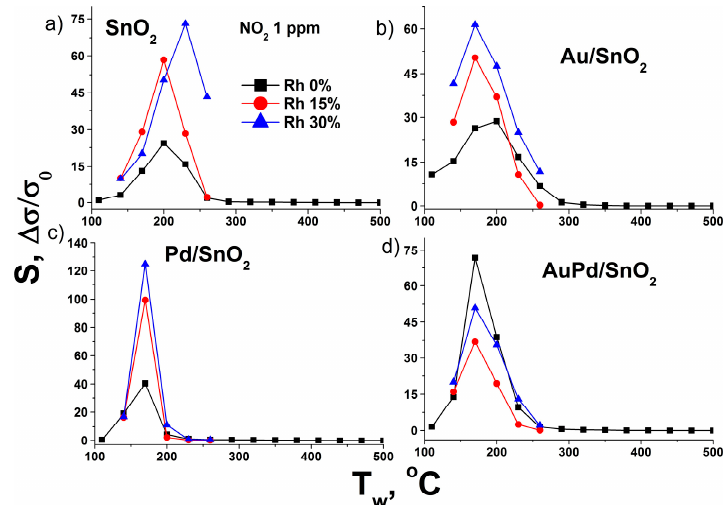
Figure 9. Sensor response dependence on the air humidity for 1 ppm of NO 2 in the case of ( a ) pure SnO 2 sample, ( b ) Au/SnO 2 , ( c ) Pd/SnO 2 and ( d ) AuPd/SnO 2 material.